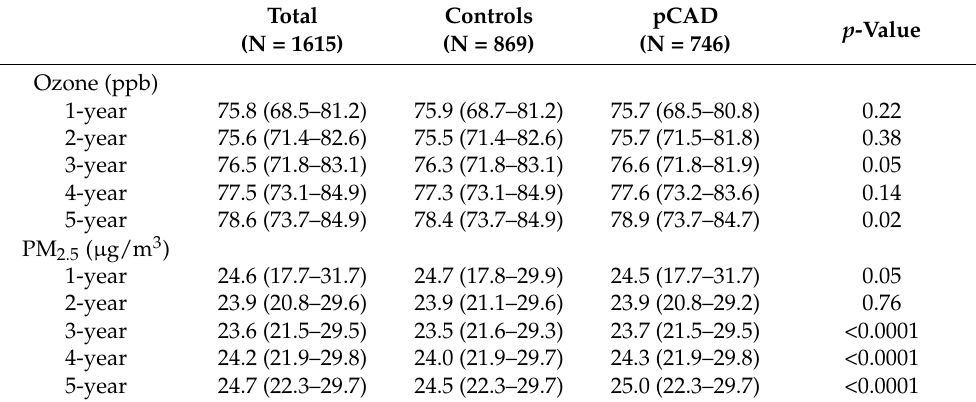
Table 2. Ambient ozone levels and PM 2.5 concentrations of the study participants: pCAD or controls. Total (N =